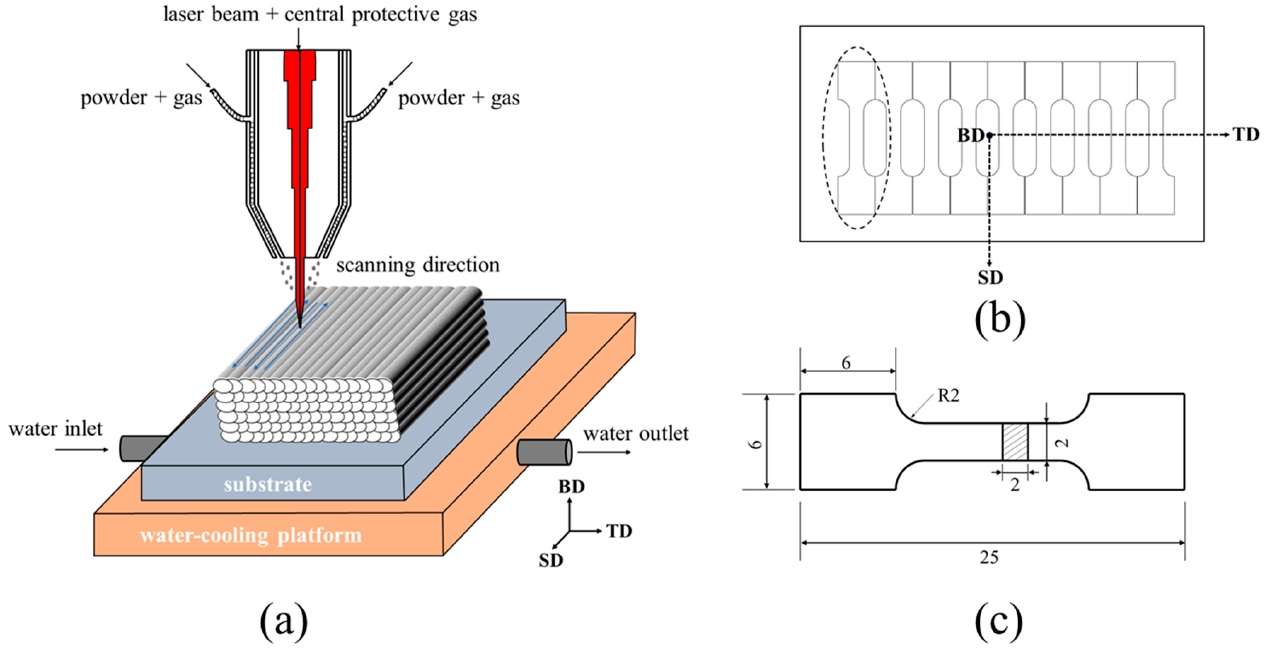
Figure 1. ( a ) Schematic diagram of sample preparation principle, ( b ) sampling methods, ( c ) tensile sample size .